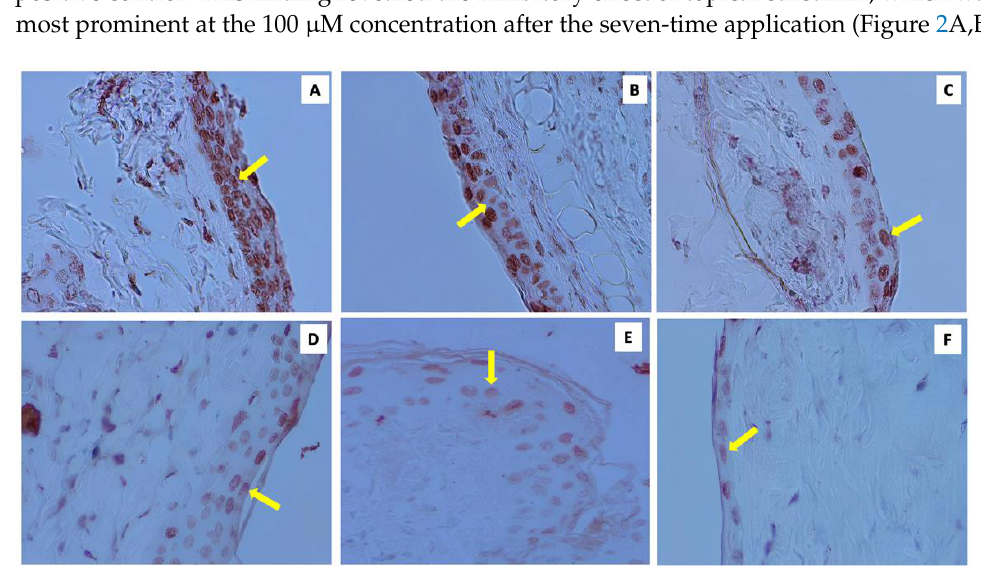
Table 1. Comparison of apoptotic cell count between one-time and seven-time curcumin application before single 343-mJ UVB exposure. Curcumin Number of Apoptotic Cells Number of Mean ± SD Mean Difference Concentration Applications 0.1 µ M